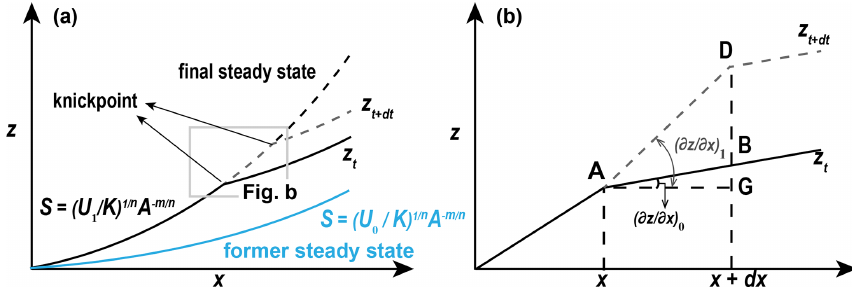
Figure 1. (a) Schematics of a channel profile evolution in response to an increase in the relative uplift rate from U 0 to U 1 (revised from Goren et al., 2014). The blue solid line shows the steady-state channel under uplift rate U 0 . The black solid and gray dashed lines show the transient channel at time t and t + d t . The black dashed line shows the final steady-state channel under uplift rate U 1 . (b) Schematics of knickpoint retreat (revised from Wang et al., 2017). Points A and D are the knickpoint positions at time t and t + d t . Evolution of the channel profile in the time step d t is shown as the transition from z t to z t + . The black dashed line AG is parallel to the x d t